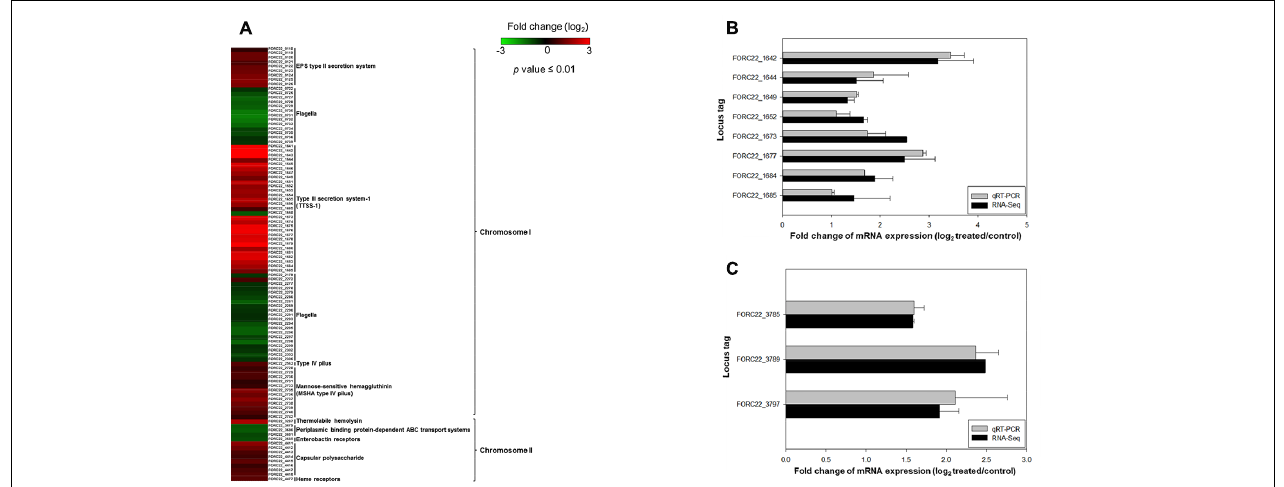
FIGURE 5 | The relatively expression of virulence genes after exposure to crabs ( p -value ≤ 0.01). (A) Fold changes of virulence genes in chromosomes I and II in heatmap. (B) Relative expression of the type III secretion system was determined by qRT-PCR. (C) Relative gene expression of the tight adhesion gene was determined. Error bars represent standard errors of the means from two independent